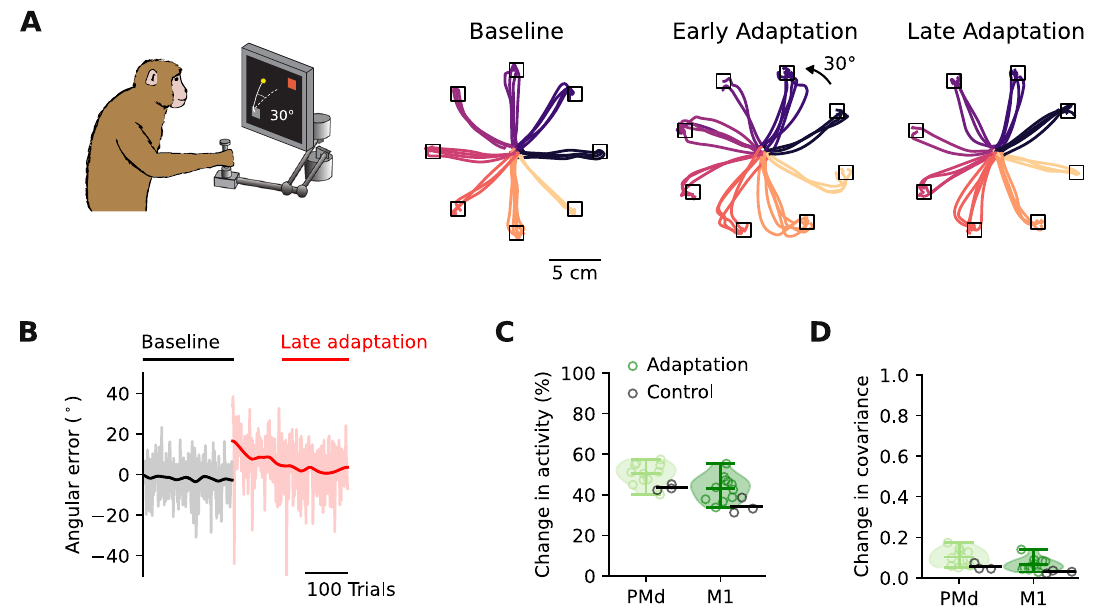
Fig. 2 | Small but measurable changes in neural activity within PMd and M1 during VR adaptation. A Hand trajectories during the fi rst 30 trials of the base- line, and the early adaptation epoch ( fi rst 150 adaptation trials), and the last 30 trials of the late adaptation epoch (last 150 adaptation trials). Trajectories are colour-coded by target. Data from Monkey C. B Angular error of the hand trajec- tories for the example session in A has the typical time course of adaptation. C Change in trial-averaged activity following adaptation. Data pooled across all